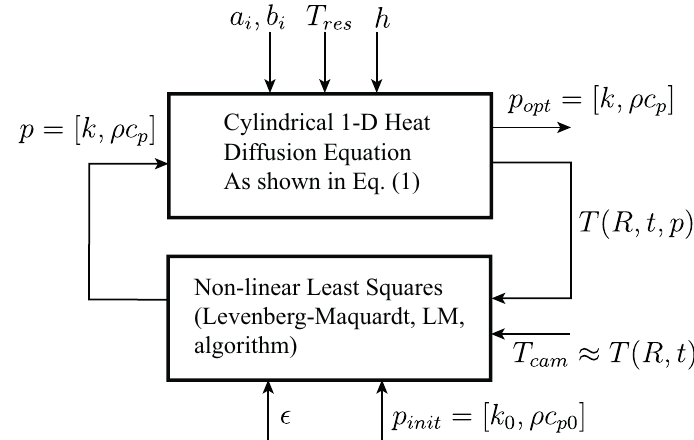
Figure 2. Methodology to address the Inverse Heat Conduction Problem (IHCP) presented above. Assuming a i , b i , T res , and h as known. T ( R , t , p ) is fitted to T cam by varying p using